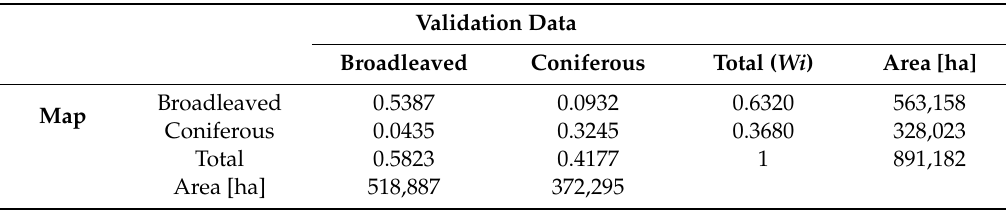
Table 7. Error matrix of estimated proportions of area (bootstrap based prediction map using Sentinel-2 derived NDVI in RLP).